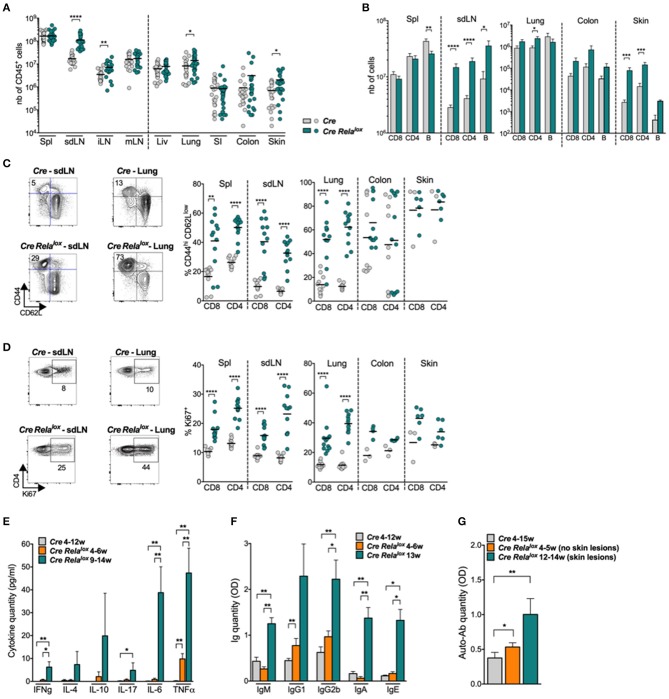
High activation of T and B lymphocytes in Foxp3Cre
Relalox mice. (A,B) Number of CD45+
(A), CD8+, CD4+, and B cells (B) in the indicated organs (spl, spleen; liv, liver; SI, small intestine) of 12 week-old Foxp3Cre (Cre) and Foxp3Cre
Relalox (Cre Relalox) mice. (C,D) Representative dot plots and proportion of CD44hi CD62Llow
(C) and Ki67+
(D) among CD8+ and CD4+ Tconv in the indicated organs of 12 week-old Foxp3Cre and Foxp3Cre
Relalox mice. (E) Cytokine quantification in the serum of 4–12 week-old Foxp3Cre, and 4–6 week-old and 9–14 week-old Foxp3Cre
Relalox mice. (F) Immunoglobulin quantification in the serum of 4–12 week-old Foxp3Cre mice, and 4–6 week-old and 13 week-old Foxp3Cre
Relalox mice. (G) Anti-DNA antibody quantification in the serum of 4–15 week-old Foxp3Cre mice, and 4–12 week-old and 12–14 week-old Foxp3Cre
Relalox mice. Each dot represents a mouse, lines and bars show the means of pooled independent experiments. Error bars represent SEM. For mouse and experiment numbers, see Supplementary Table 1. The two-tailed unpaired non-parametric Mann–Whitney U-test was used for data not following a normal distribution and the t-test was used for data following a normal distribution. *p < 0.05, **p < 0.01, ***p < 0.001, ****p < 0.0001.